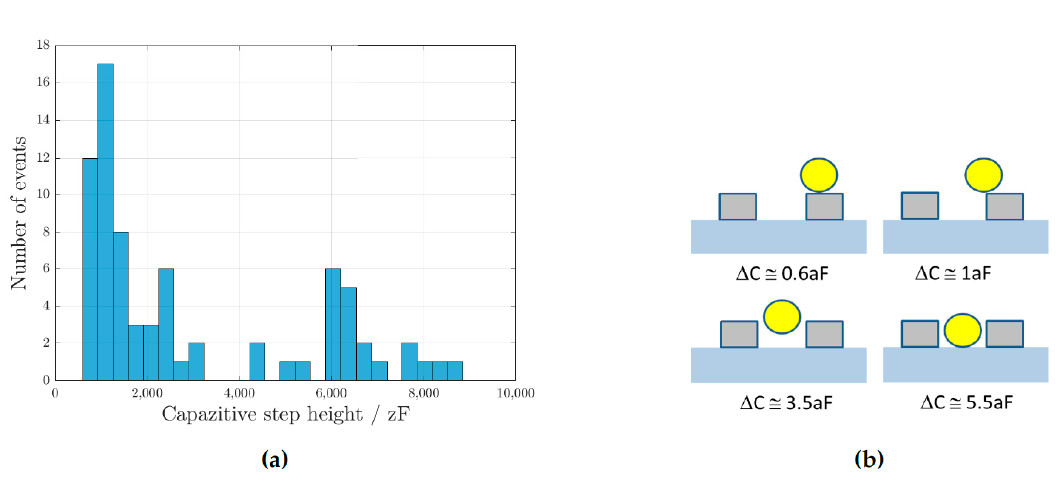
Figure 4. ( a ) Histogram of the observed capacitive changes caused by monodisperse 1 µm PSL particles. ( b ) Simulation of the sensor’s response to the monodisperse 1 µm PSL particles. The position of the particles relative to the electrodes has a significant impact on the